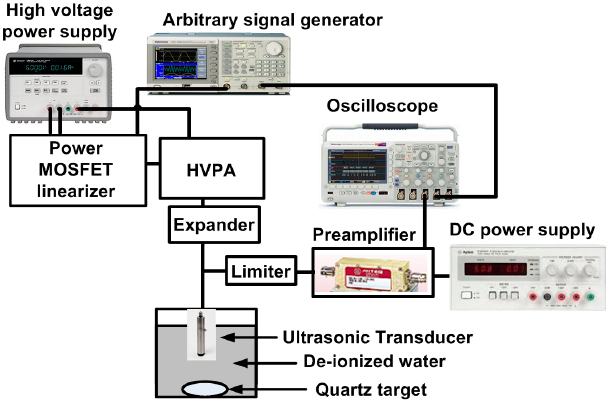
Figure 9. The measurement setup for the high frequency pulse-echo instrumentation.